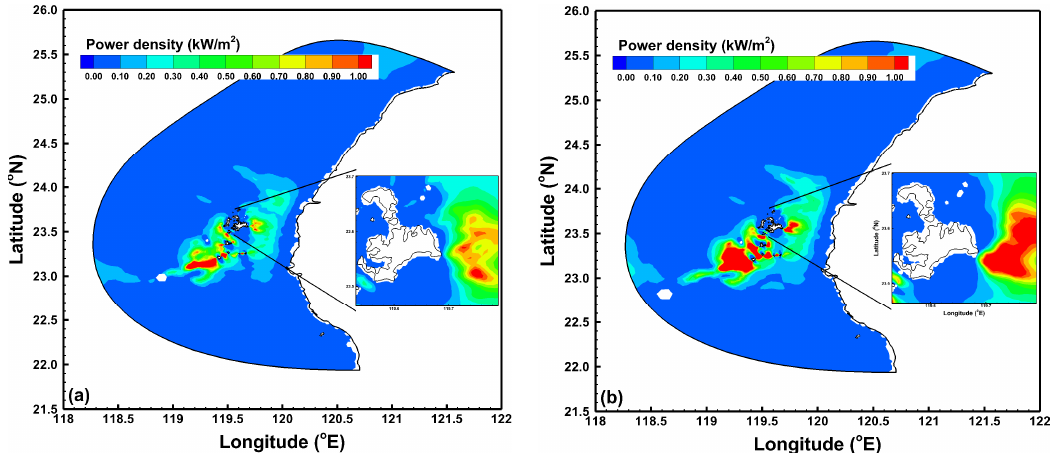
Figure 6. Power density distribution around Taiwan Strait at the ( a ) mid-flood; and ( b ) mid-ebb of the mean spring tide.